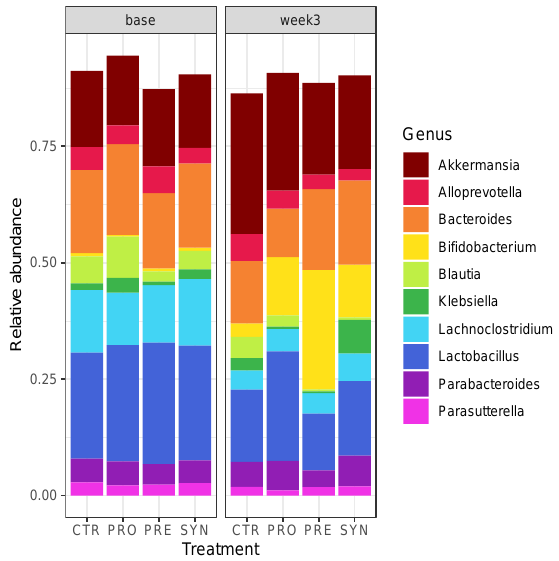
Figure 7. Bar plot of gut microbiota composition at the genus level at baseline and three weeks post-treatment. n = 12/group.